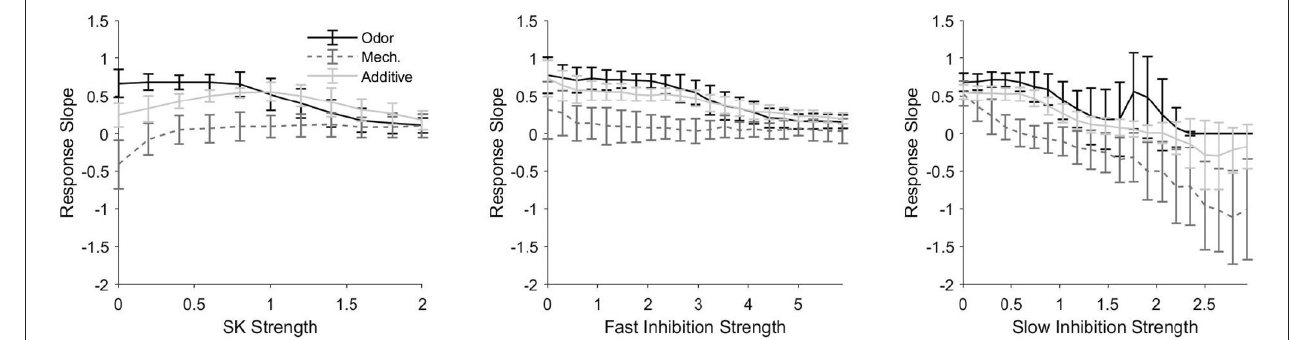
FIGURE 4 | Response slope, defined as the slope of the best fit line for a response length vs. pulse length plot (i.e., plots as in Figure 3A ), as a function of the strength of the SK current (left), fast inhibitory synapses (center), and slow inhibitory synapses (right) within the model. A larger (more positive) response slope indicates a greater sensitivity to pulse length, or, in other words, a greater ability of the temporal length of the spiking response to be indicative of the temporal length of the stimulus pulse. In the odor only and additive stimulus scenarios, the PN is taken from an odor-receiving glomerulus; data are shown for a single sample PN and averaged over 50 trials. Values on the x-axes are normalized by the standard strength employed in the model (i.e., 1 represents the standard strength employed for each current in the